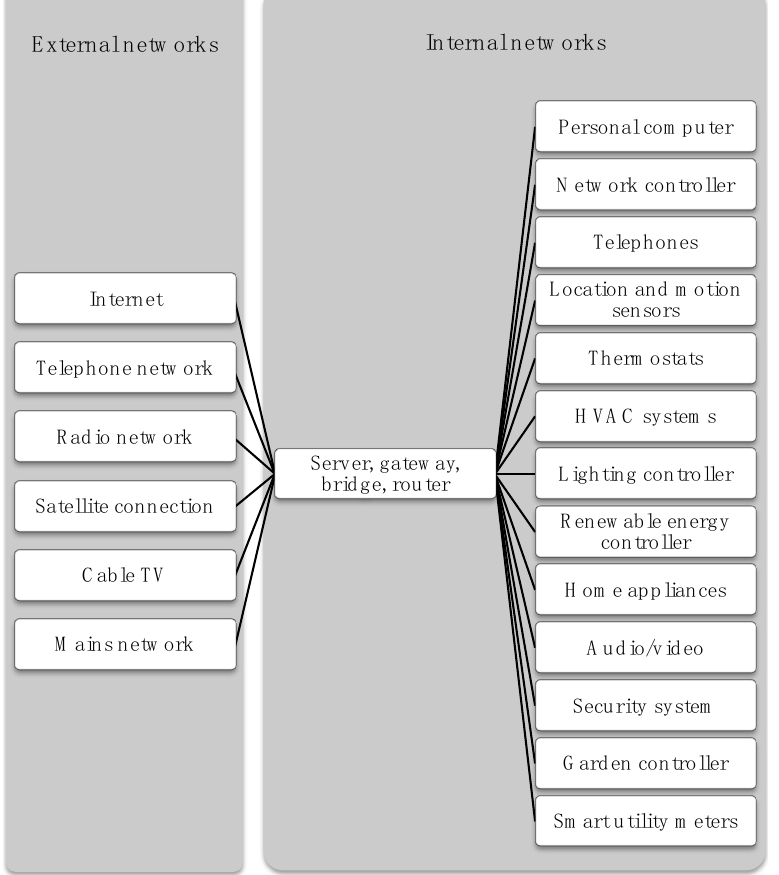
Figure 2 . Top-level architecture of a typical smart home. Modified from reference [50]. Figure 2. Top-level architecture of a typical smart home. Modified from reference